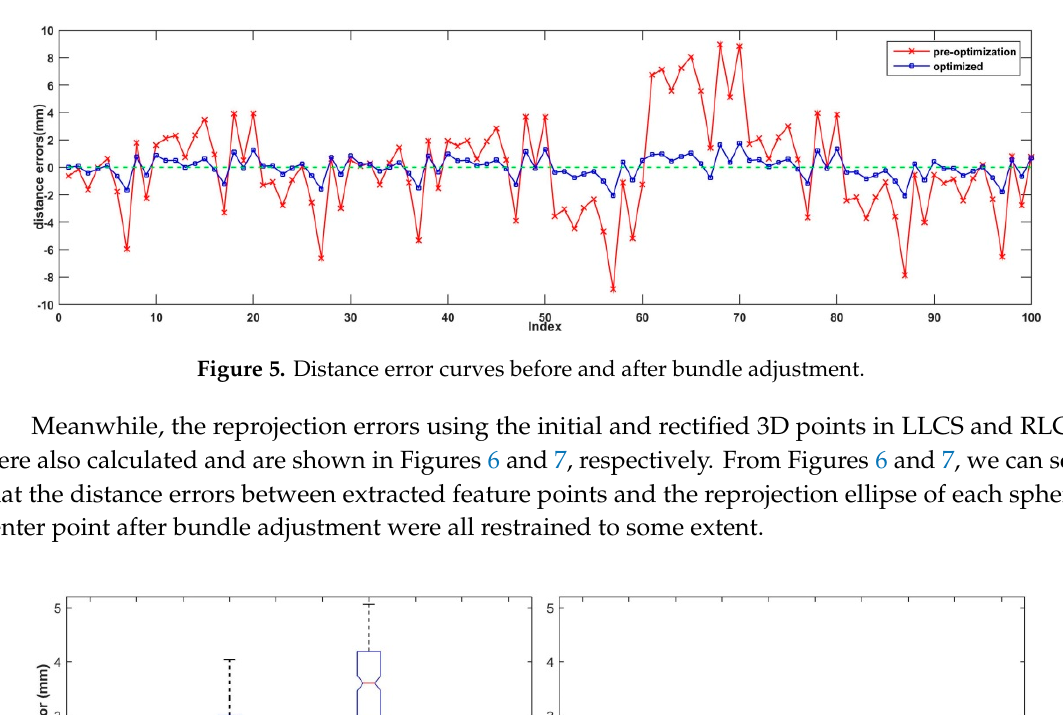
Table 4. Extrinsic parameters between two cameras before and after optimization.